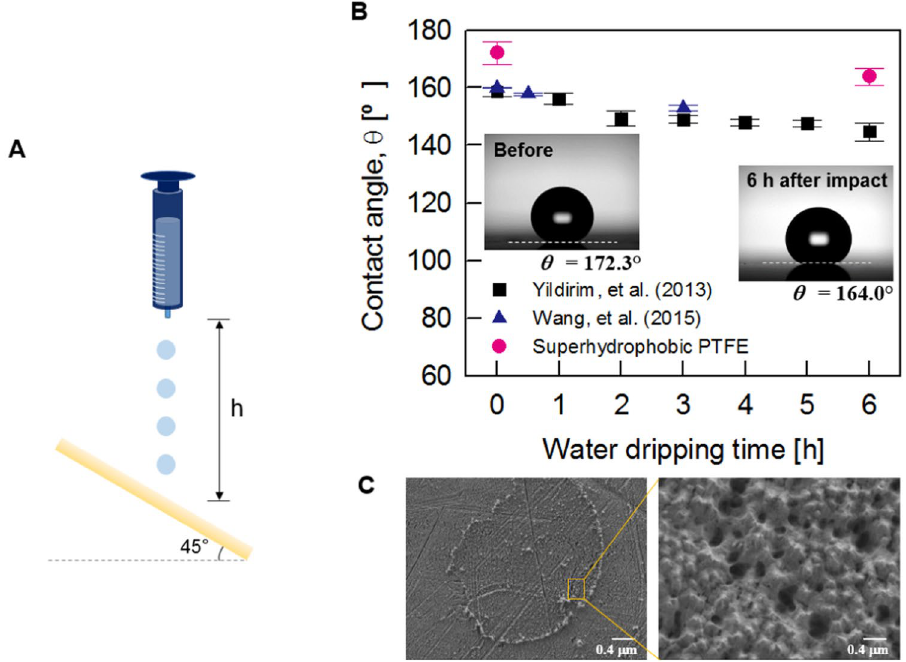
Figure 4. Stability of superhydrophobicity of the fabricated PTFE sheets as a function of excessive water dripping time. ( A ) In the water dripping test, water droplets (~8.6 μ L) impacted the PTFE inclined at 45° from h = 10 cm at a rate of one drop per second. ( B ) Variation of the water contact angle of the superhydrophobic surfaces with the lapse of time for 6 h of water dripping of Yildirim, et al . (marked by black square), Wang, et al . (marked by blue upper-triangle), and the present superhydrophobic PTFE (marked by red circle). The contact angle of the fabricated superhydrophobic PTFE is slightly decreased, similar to that of the other results. ( C ) SEM images of the superhydrophobic surfaces after the water dripping test. The mark of droplets impacting on the surfaces was remained at the specific point where the water droplet impacted (left). The enlarged image shows that the nanostructures of the initial superhydrophobic surface are almost maintained